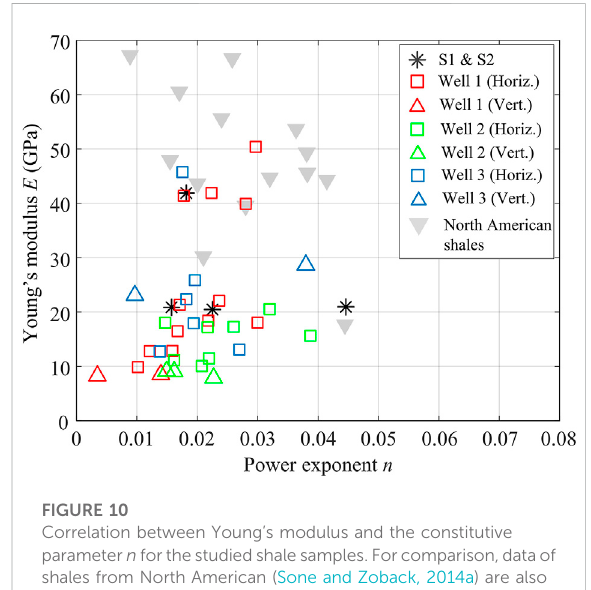
FIGURE 10 Correlation between Young ’ s modulus and the constitutive parameter n forthestudiedshalesamples.Forcomparison,dataof shales from North American (Sone and Zoback, 2014a) are also